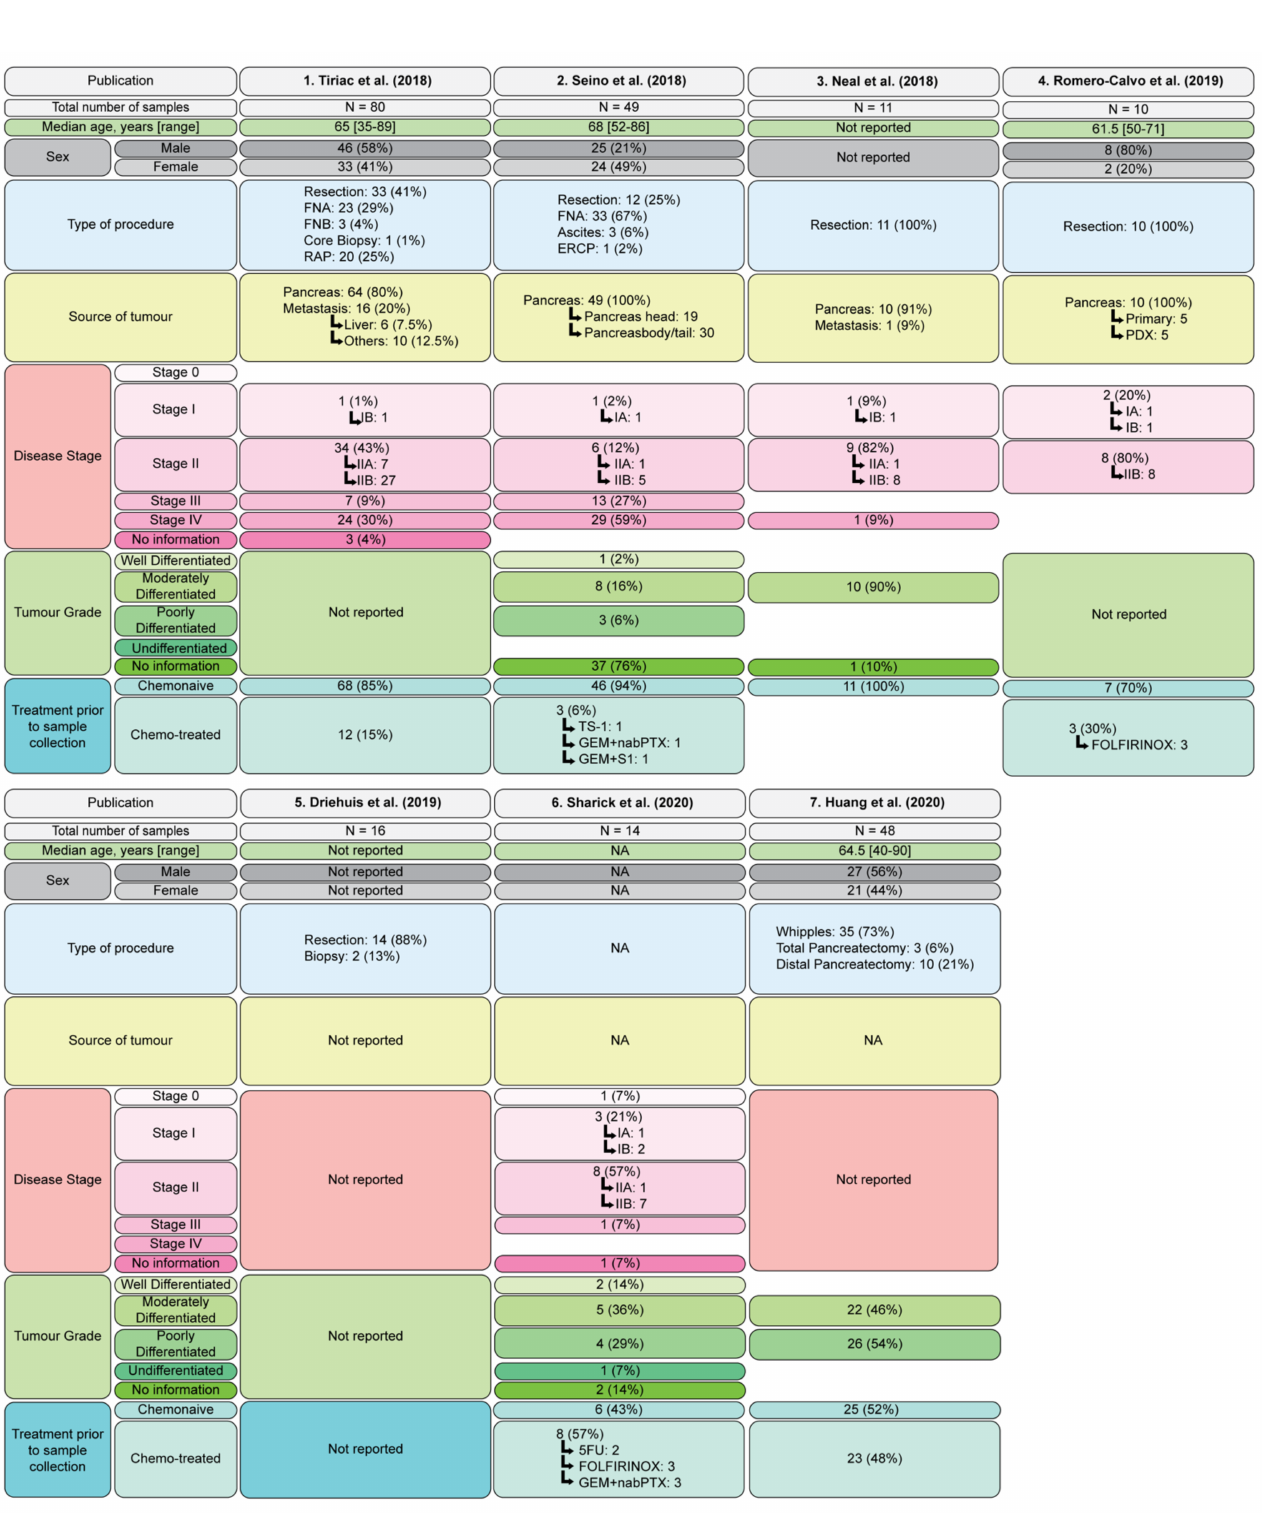
Figure 3. Features of PDAC organoid biobanks. Summary of the seven PDAC organoid biobanks described to date [47–53], including total number of samples, median age, sex, type of procedure, source of tumor, disease stage (according to AJCC Cancer Staging Manual, Eight Edition [11]) and treatment prior to sample collection. Abbreviations: Source of tumor: PDX, patient derived xenograft. Treatment prior to sample collection: chemotreated: GEM, gemcitabine; nabPTX, nab-Paclitaxel; FOLFIRINOX, fluororacil (5FU)+folinic